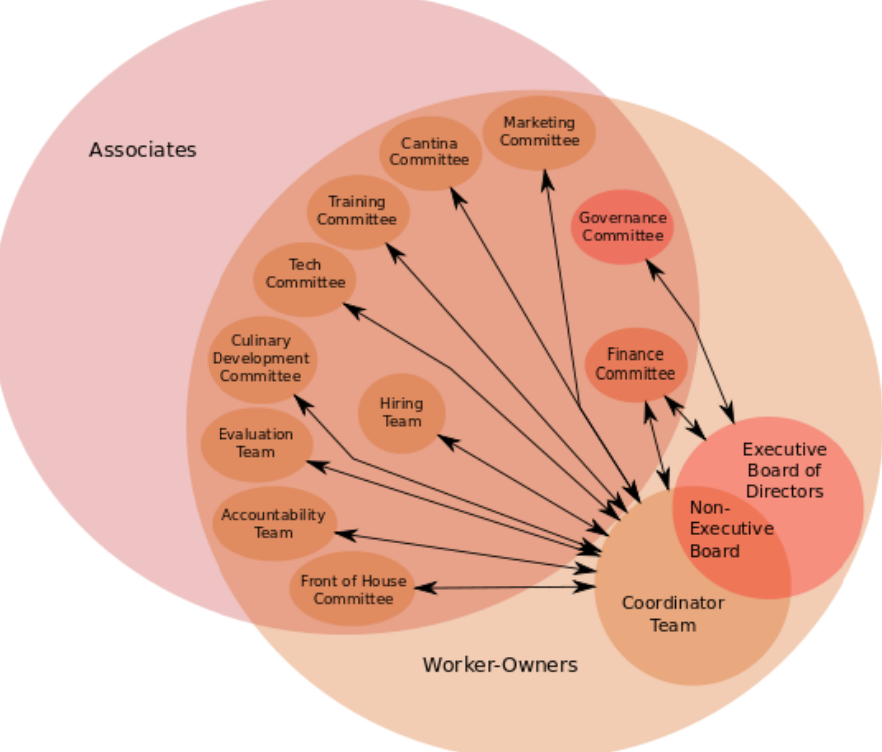
Figure 1. Ownership and management structure of Casa Nueva restaurant. Source: (Casa Nueva n.d.b).